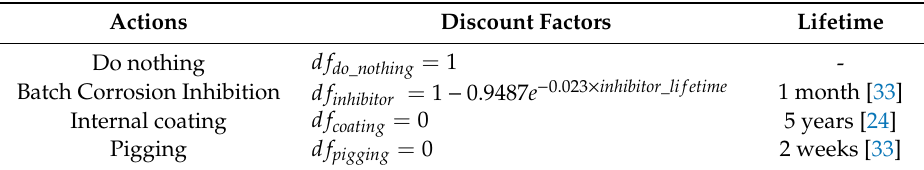
Table 3. Discount factors and lifetime of maintenance